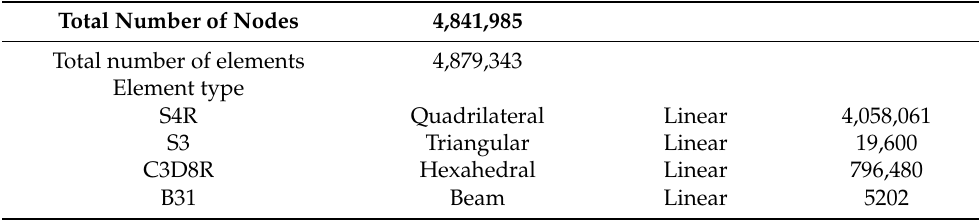
Table 2. Mesh statistics for the refined model.